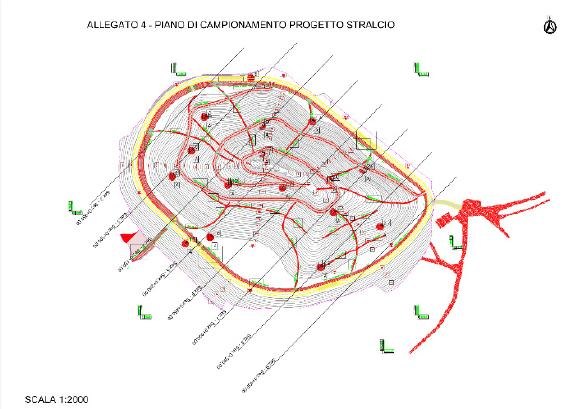
Figure 5 . Disposal site cross sections of working stages